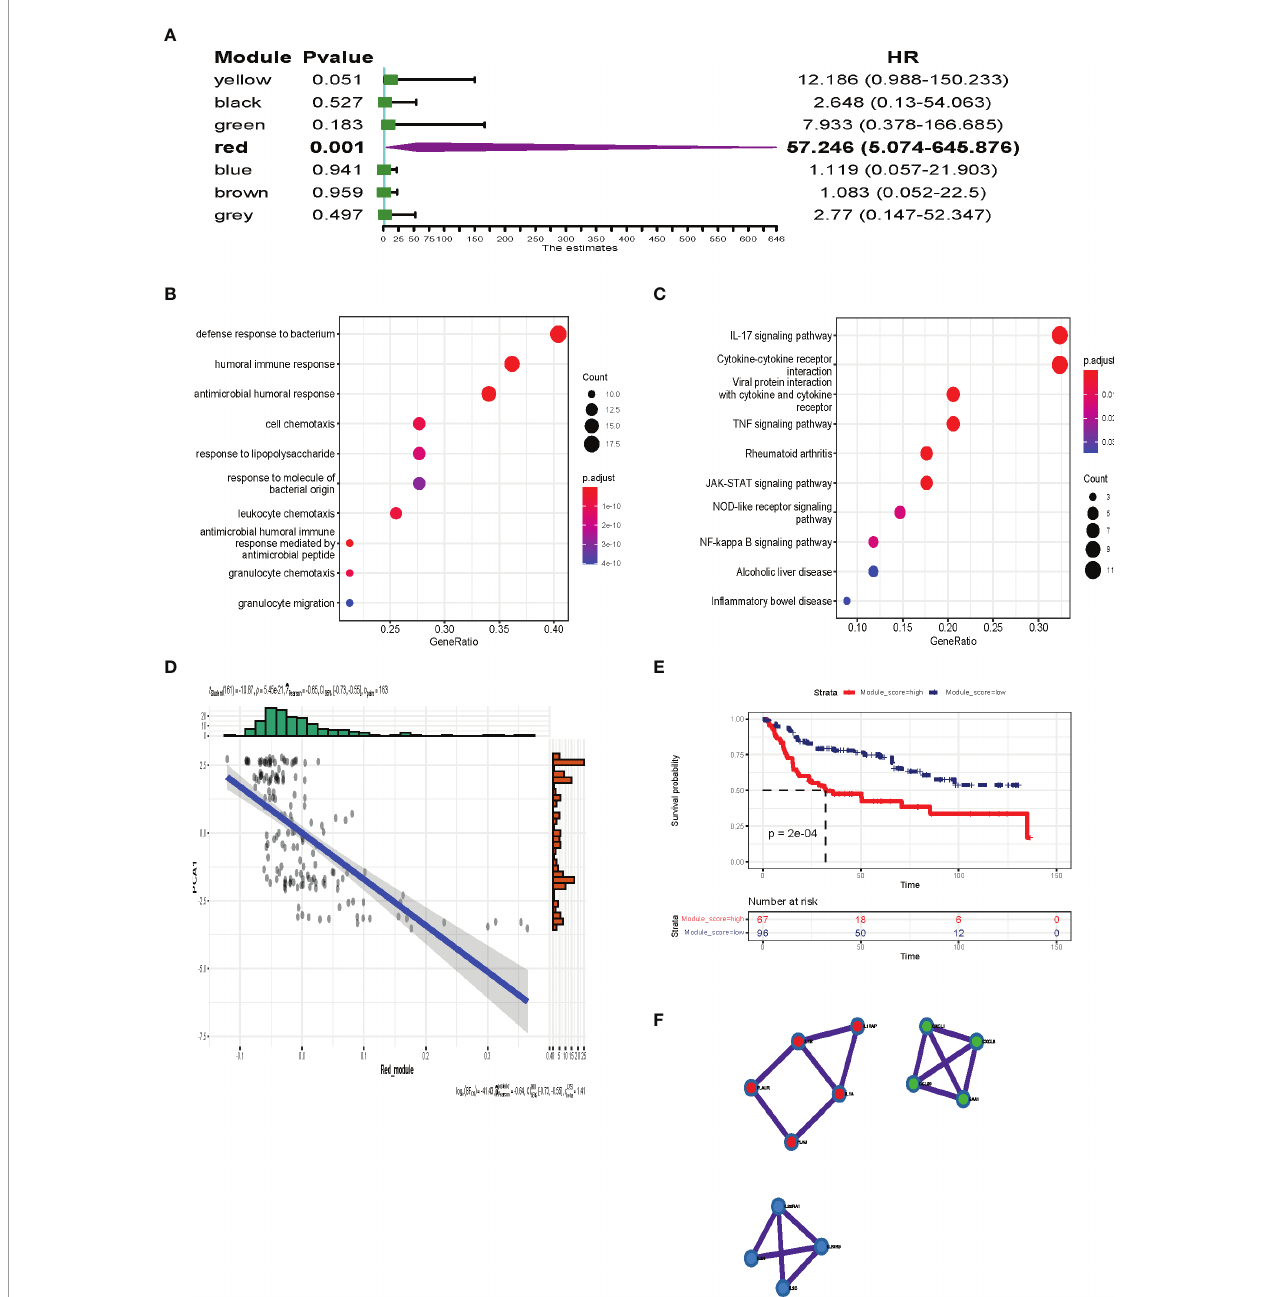
FIGURE 10 | Identi fi cation of the hub gene for BLCA mRNA vaccines. (A) Forest maps of single factor survival analysis of 7 modules of BLCA. (B, C) Dot plot showing top 10 GO terms (B) and KEGG (C) in the red module. The dot size and color intensity represent the gene count and enrichment level, respectively. (D) Correlation between the red module feature vector and fi rst principal component in the immune landscape. (E) Differential prognosis in the red module with high and low mean. (F) 13 hub genes identi fi ed in red